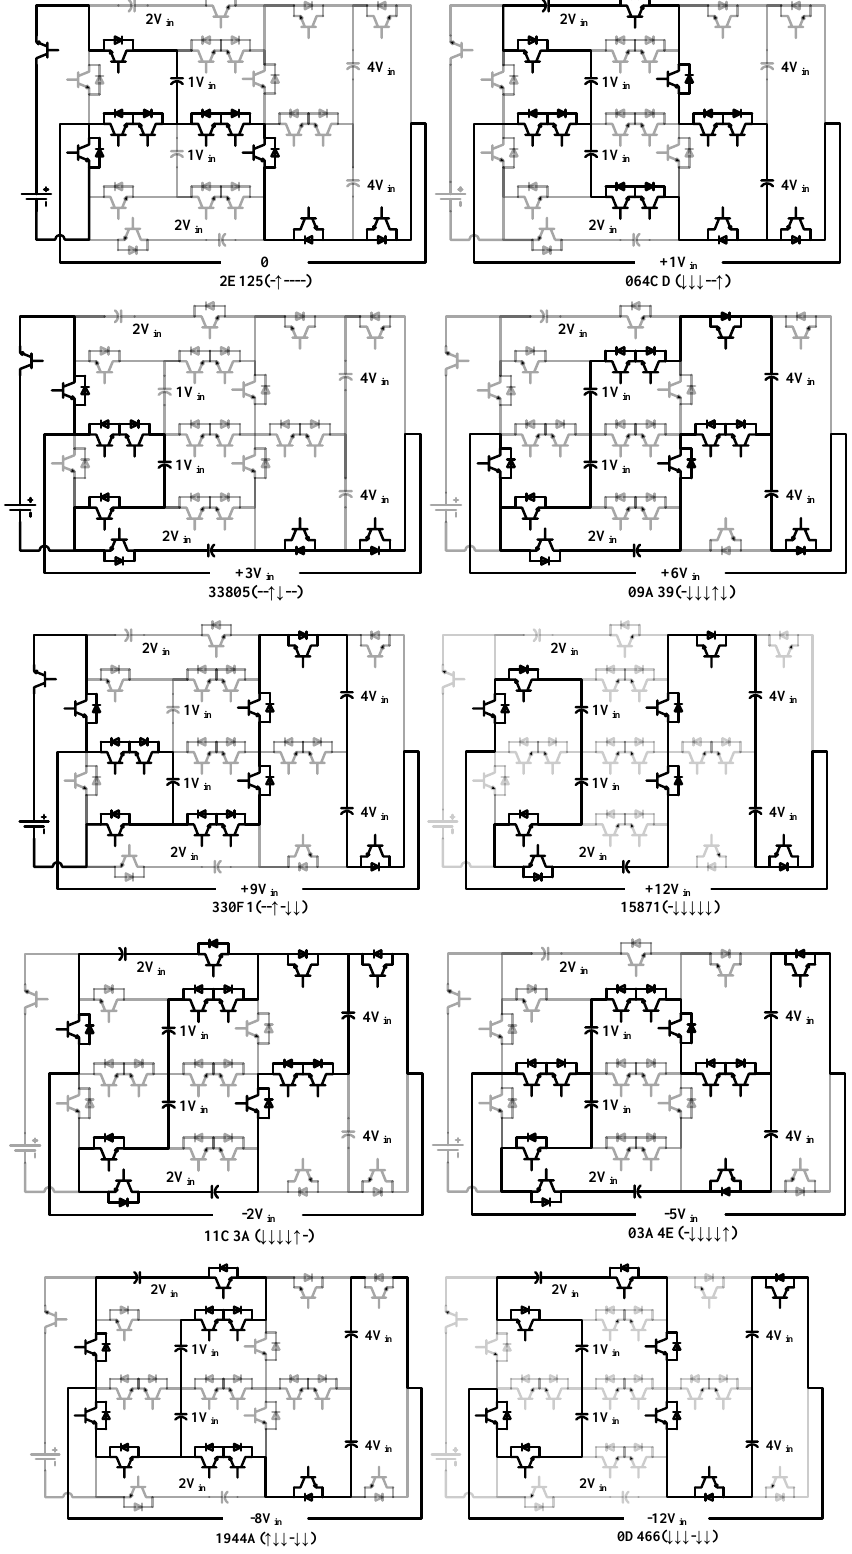
Figure 4. A few selected discharging paths related to the switching states of Table 1.